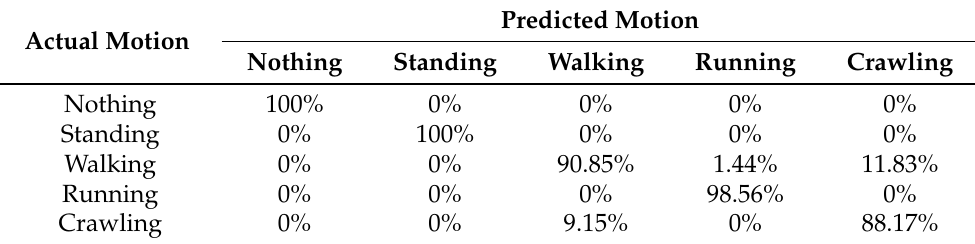
Table 2. Classification results from the CNN-based classifier (Case 1).